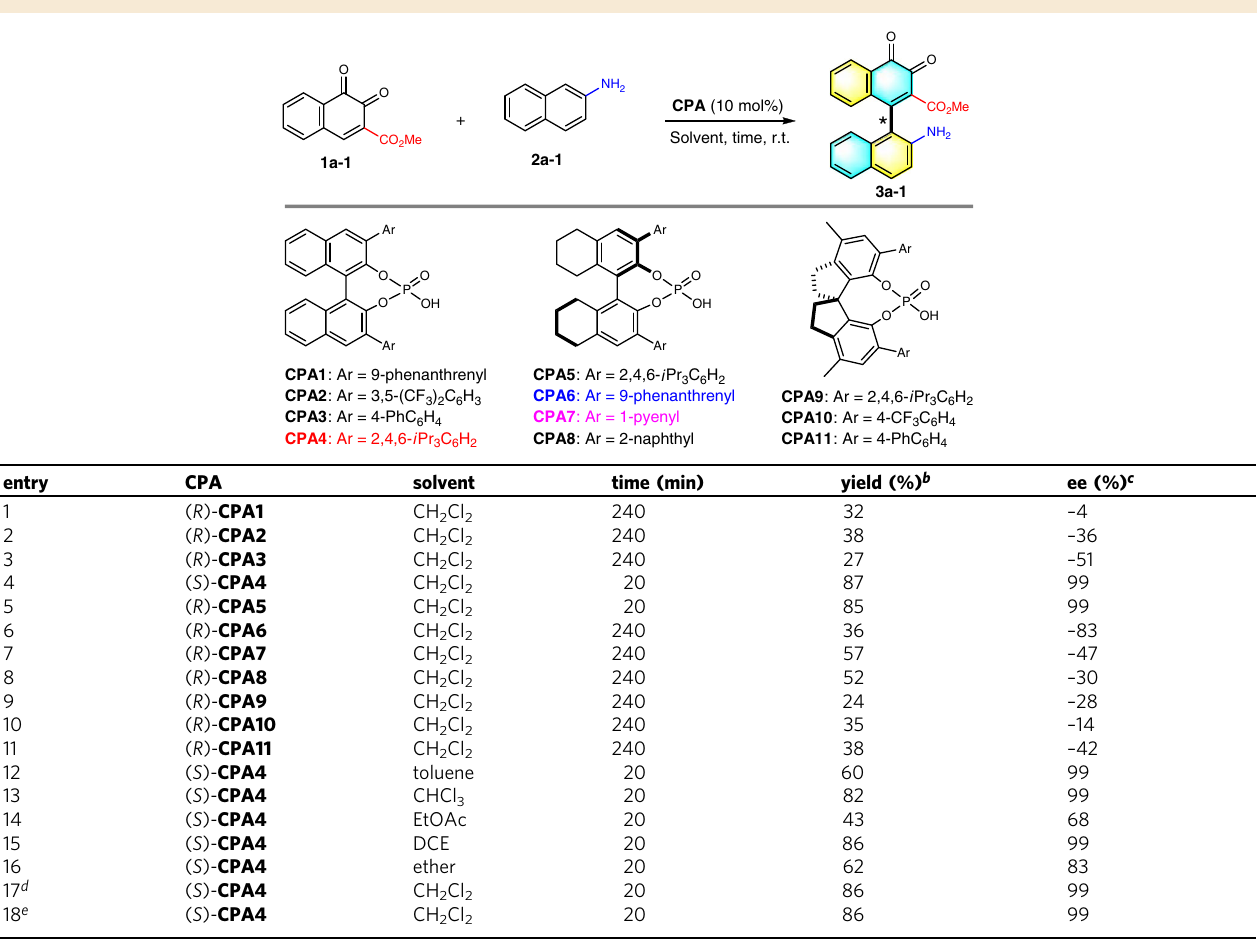
CPA (10 mol%) Solvent, time, r.t.